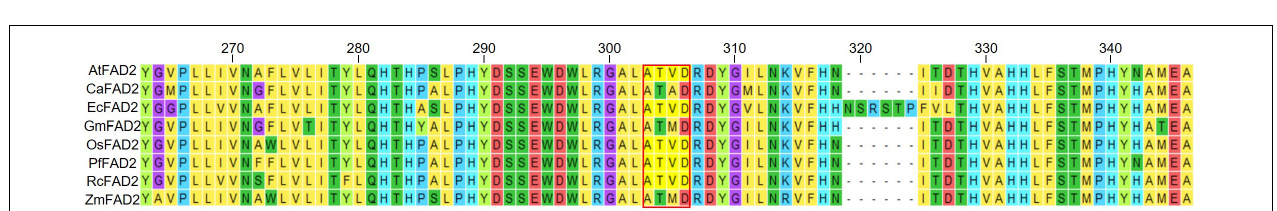
FIGURE 5 | Alignment of FAD2 amino-acid sequences among Arabidopsis and various oil crops. Protein alignment was conducted by ClustalW in the MEGA7 program focusing on the g5 region in this study. The red box indicates the base editing window in this study. At, Arabidopsis thaliana ; Ca, Corylus avellana ; Ec, Eucalyptus camaldulensis ; Gm, Glycine max ; Os, Oryza sativa ; Pf, Physaria fendleri ; Rc, Ricinus communis ; Zm, Zea mays. Different colors of amino acid are based on the polarity of the R group.